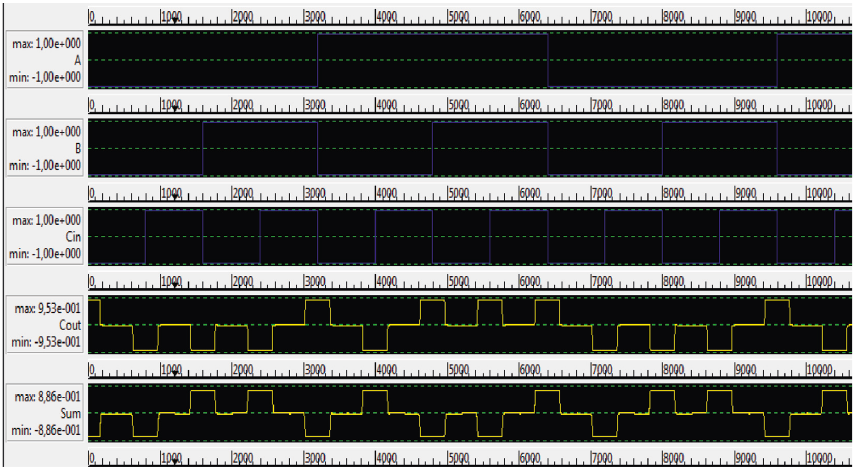
Figure 8: Simulated input-output waveform of the proposed FA